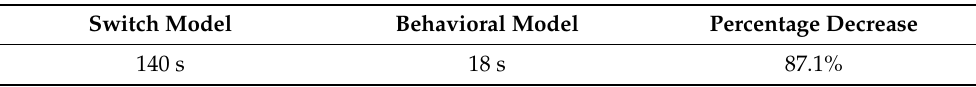
Table 3. Simulation time comparison for the switch model and behavioral model of dc nanogrid- based